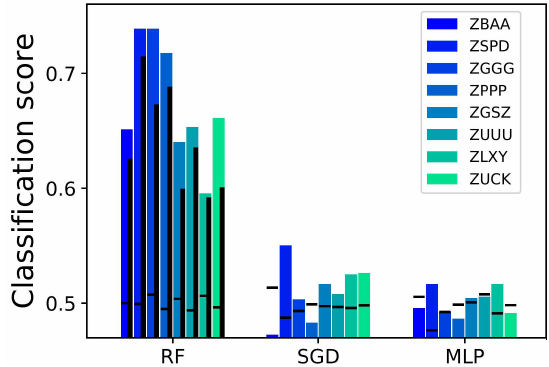
Figure 7. Classification score obtained by three standard data mining algorithms (see Section 3.4 for definitions), for the problem of forecasting the binarized delay at each airport. The horizontal dashes represent the average value obtained in a classification in which labels have randomly been shuffled. Additionally, the vertical black bars alongside RF results indicate the classification score obtained when predicting the delays for days without